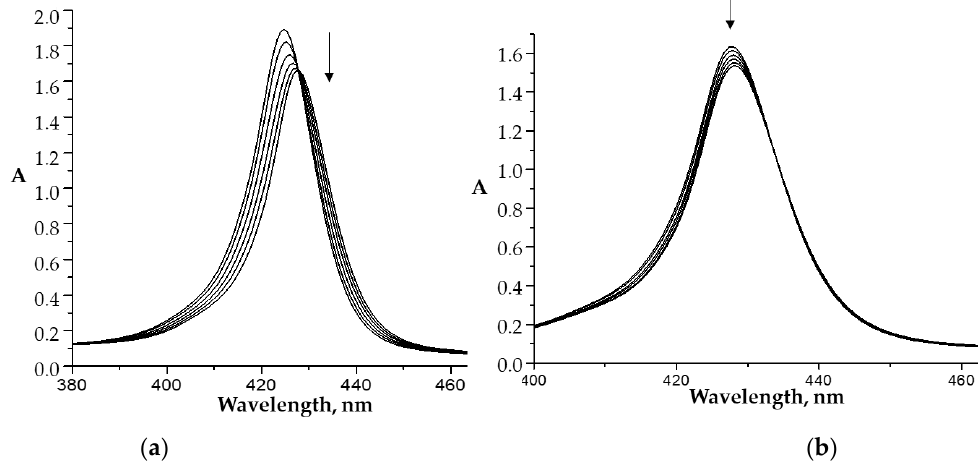
Figure 2. UV–Vis spectra (Soret band region) of the СоP1(H 2 O) 2 (С porph. - 9.8 × 10 −6 M) in phosphate buffer (pH 7.4) at 25 ° С upon titration with L1 (C L1 = 0 ÷ 5.9 × 10 −6 M ( a ) and C L1 = 5.9 × 10 −6 ÷ 1.9 × 10 −4 M ( b )). Table 1. Energies of Co(III)P-(L)(H 2 O) and Co(III)P-(L)(H 2 O) formation (−ΔG1 and −ΔG2, kJ × mol −1 ), calculated values of the Gibbs energy of the bis -axial complexes (−ΔG2, kJ × mol −1 ), length